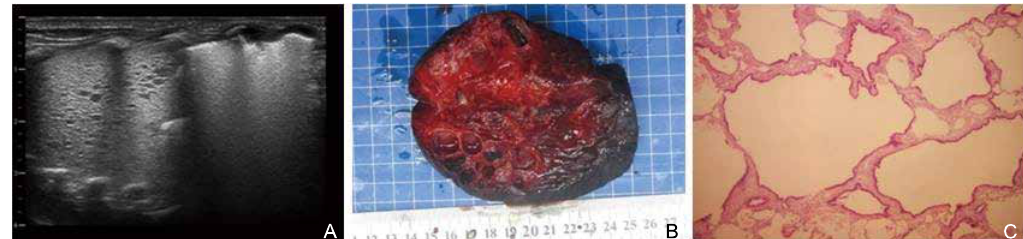
Figure. 2 Ultrasonography and pathologic manifestations in type 2 CPAM: (A) A cystic mass with a honeycomb appearance and the diameter of cystic cavities ranging from 4 to 9 mm in diameter. The cystic wall was thickened, and there were normal echoes inside the mass. (B) Gross photo of resected specimens. (C) Microscopy showing many cysts, lined by stratified columnar epithelium and having thin fibromuscular septa.